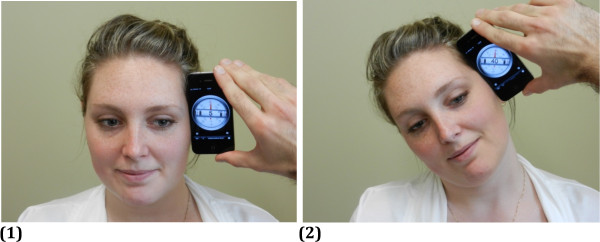
Position of the iPhone for the measurement of right lateral flexion. (1) Starting position. (2) Position at end range of right lateral flexion. The iPhone’s level is aligned with the corner of the eye.